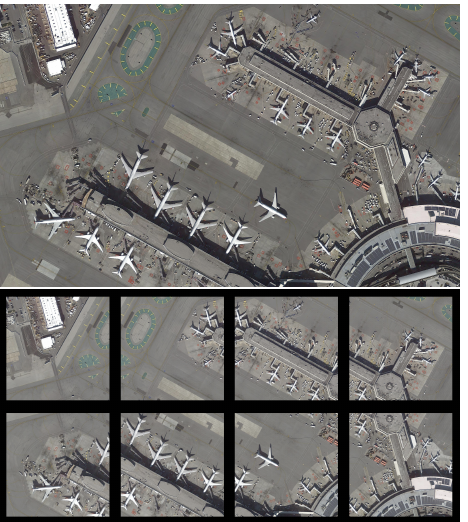
Figure 2. Demonstrate the effect of processing the input image into a fixed